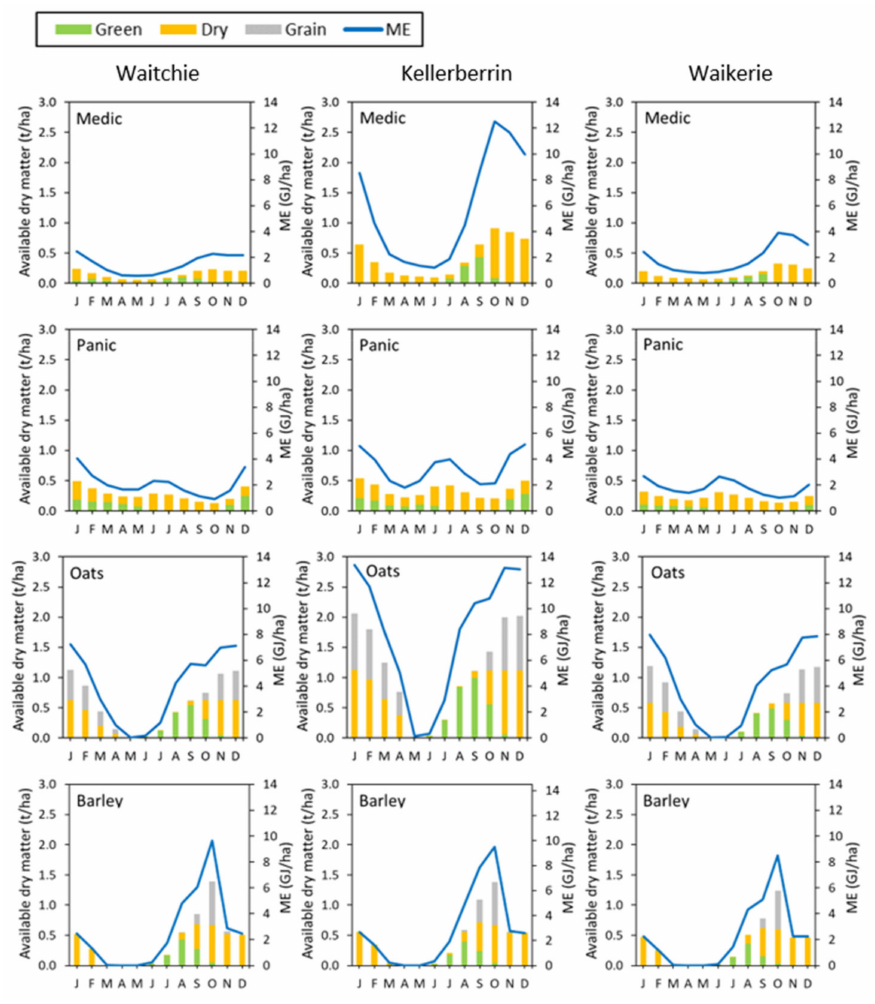
Figure 7. Long term average, monthly (January to December) standing green (green bar) and senesced (yellow bar) biomass, and available metabolizable energy (line) of the animal-available dry matter for annual legume (medic), perennial Panic grass, crop (standing, unharvested oats and harvested barley) at Waitchie (first column), Kellerberrin (middle columns) and Waikerie (last columns) with 769 shrubs/ha. Grey bars indicate the harvested barley grain. Note the data are for non-defoliated interrow and have been reset annually to a common residual dry matter at the start of